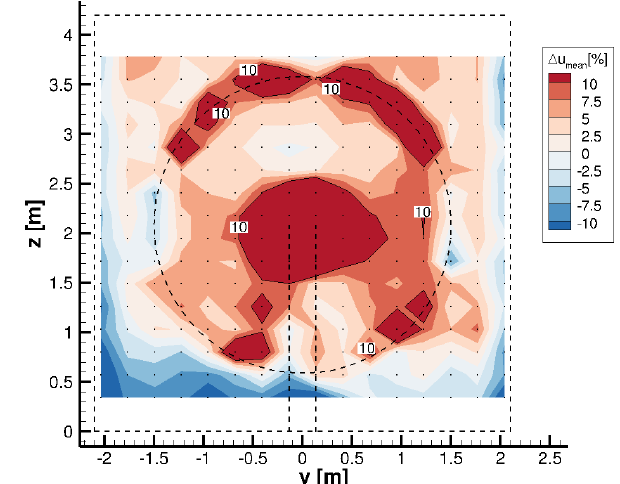
Figure 11. Relative velocity difference between measurement and simulation with regard to the undisturbed reference inflow veloc- ity of 6 . 5ms − 1 , 0 . 5 d downstream of the rotor plane. The dashed lines illustrate the wind tunnel and the turbine. Isolines show 10% deviation. The dots show the discrete evaluation points.